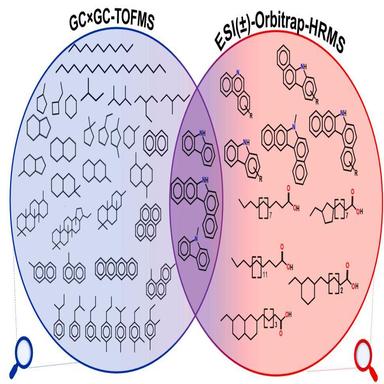
Selected chemical structures of assigned hydrocarbons classes and polar compounds identified using GC × GC-TOFMS and ESI(±)-Orbitrap-HRMS.